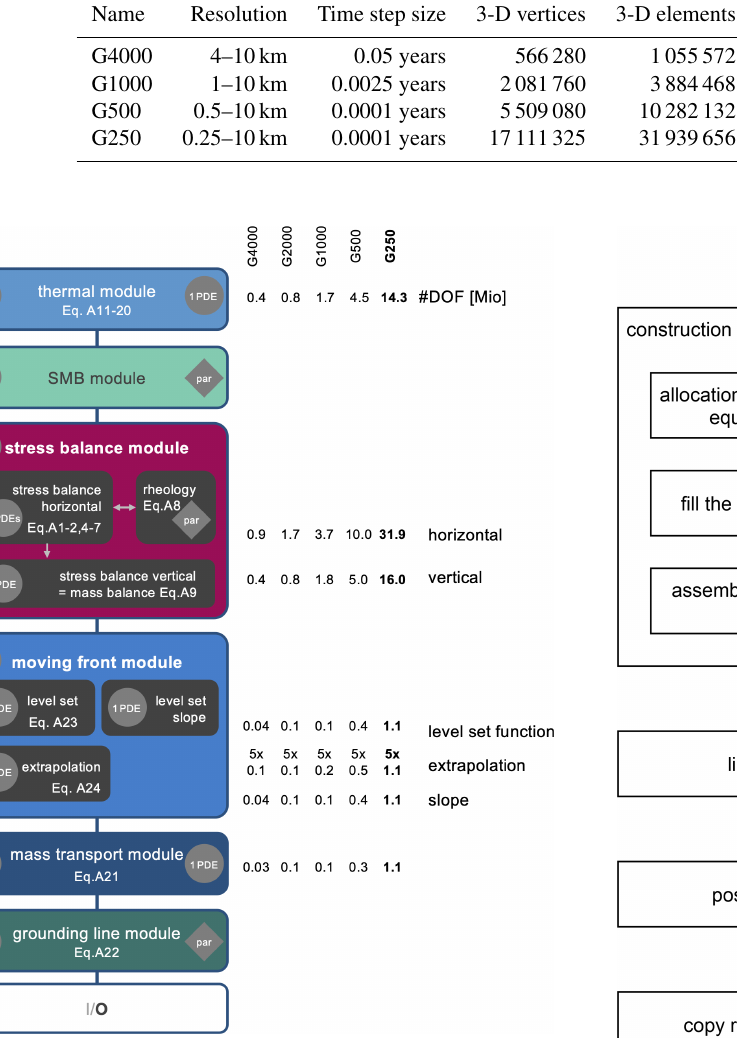
Figure 2. Sketch of a solution sequence of